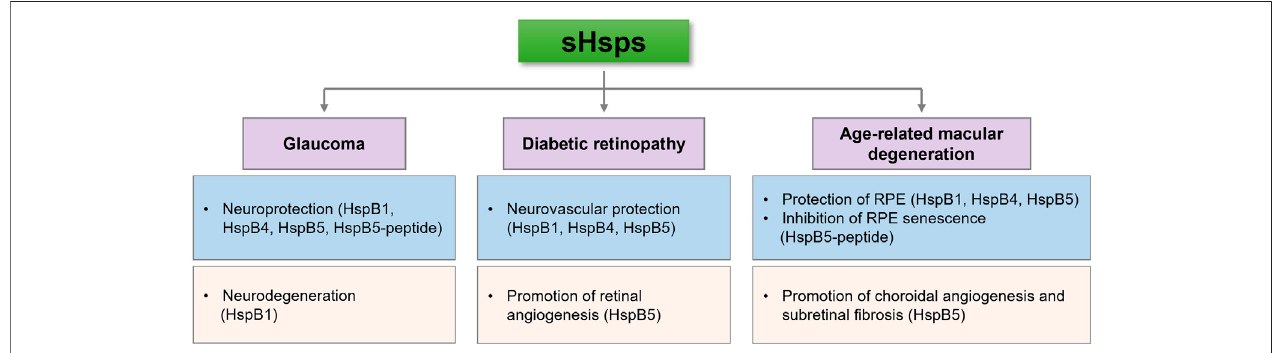
FIGURE 1 | sHsps can inhibit or contribute to the pathogenesis of retinal diseases. This seemingly contradictory ability might depend on their cell type expression, response to stress and posttranslational modi fi